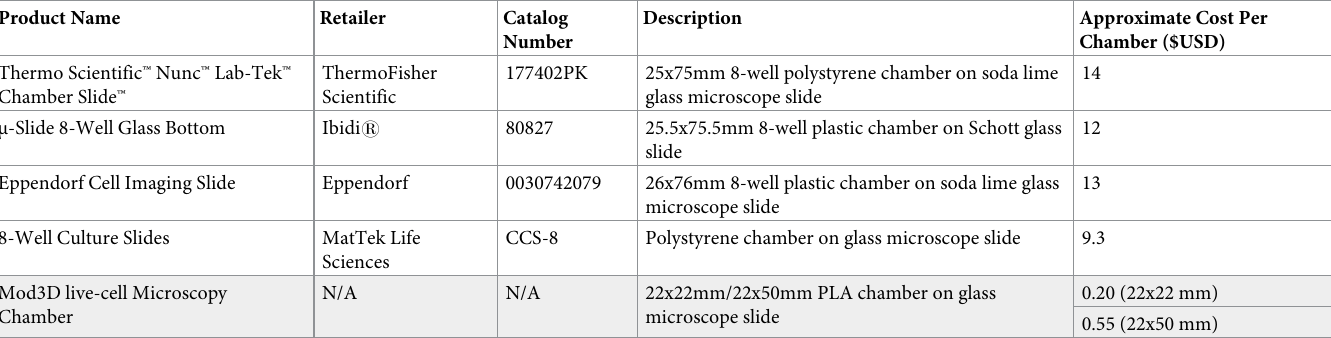
Table 1. Cost comparisons of commercially available imaging chambers and the 3D printed microscopy